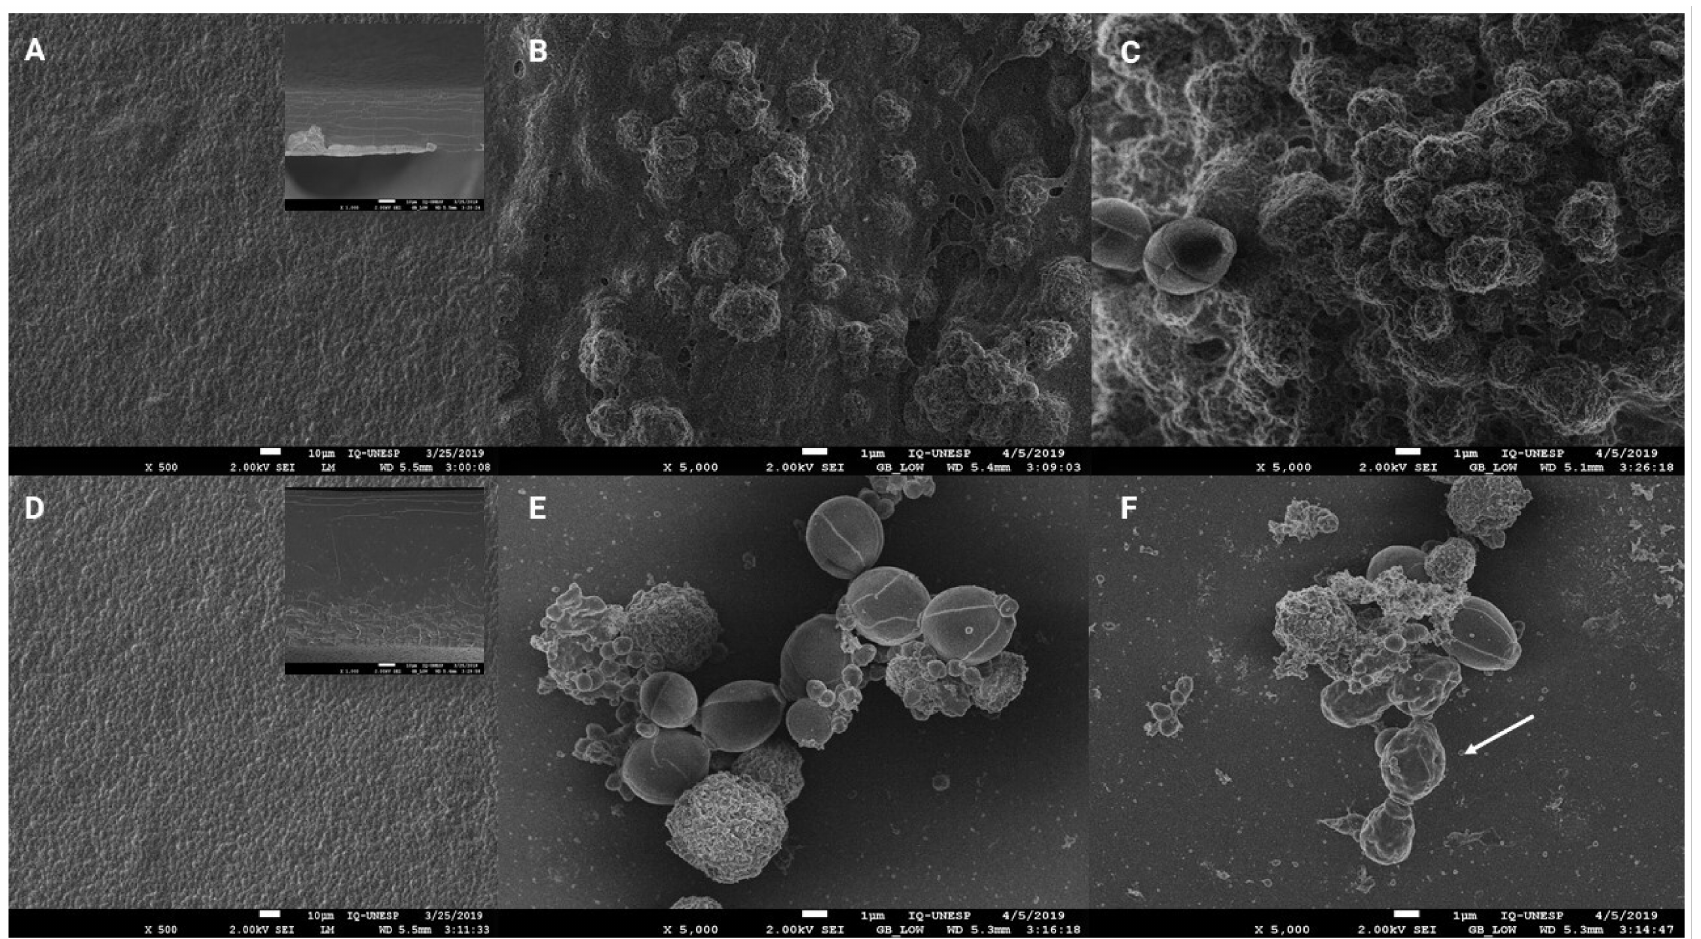
Figure 5. FEG-SEM images. Surface of the ODFs: ( A ) CF 500 × and ( D ) PF 500 × . The respective cross-sections of each ODF were taken at 1000 × and are embedded into the right-hand corner of ( A , D ). Biofilms at 5000 × magnification: C. albicans + CF early ( B ); C. albicans + CF mature ( C ); C. albicans + PF early ( E ); C. albicans + PF mature ( F ). The arrow indicates the wrinkled morphology of C. albicans after 48 h in the presence of